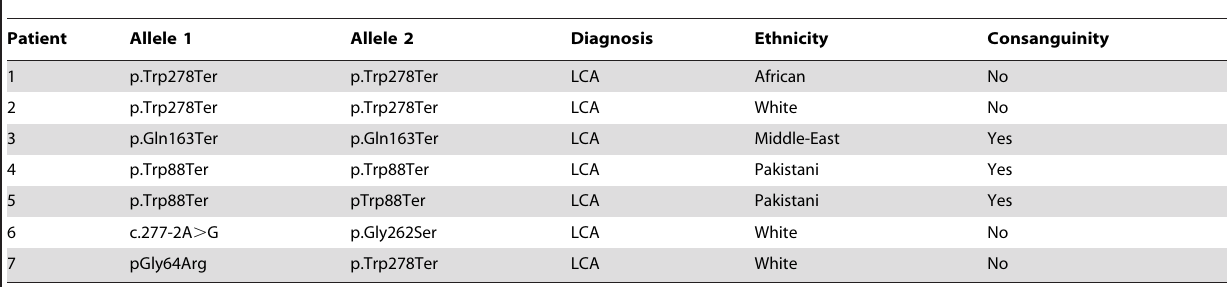
Table 3. Patients with disease-causing mutations in AIPL1